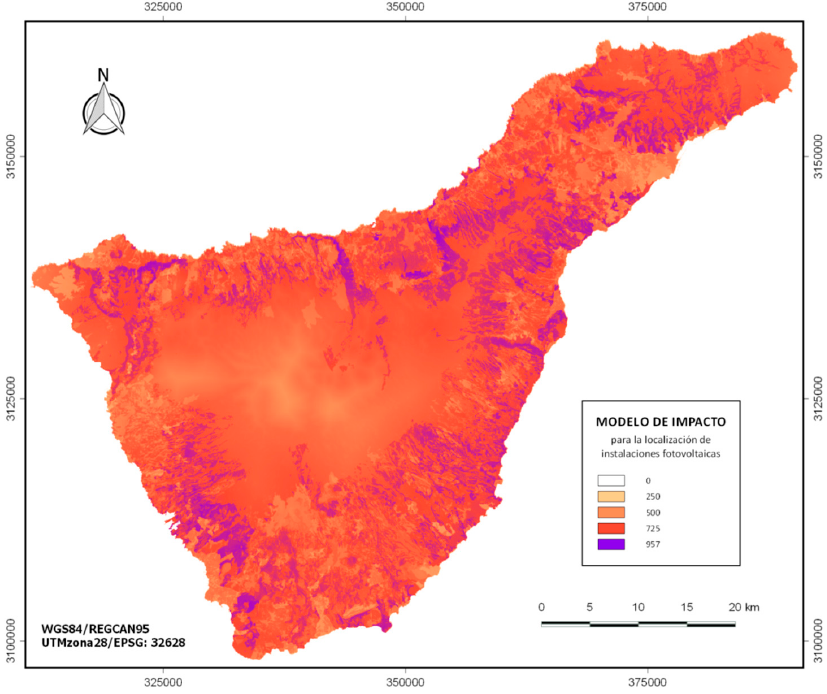
Figure 3. Impact Model.